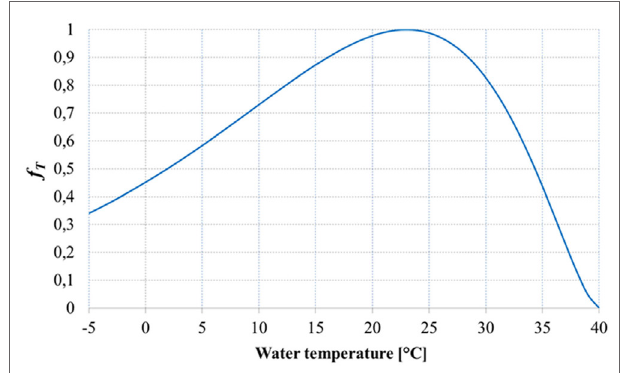
FigUre 4 | Temperature factor (slegers et al., 2013)